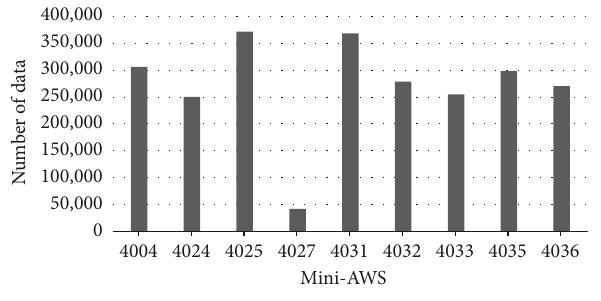
Figure 4: Number of collected Mini-AWS data.